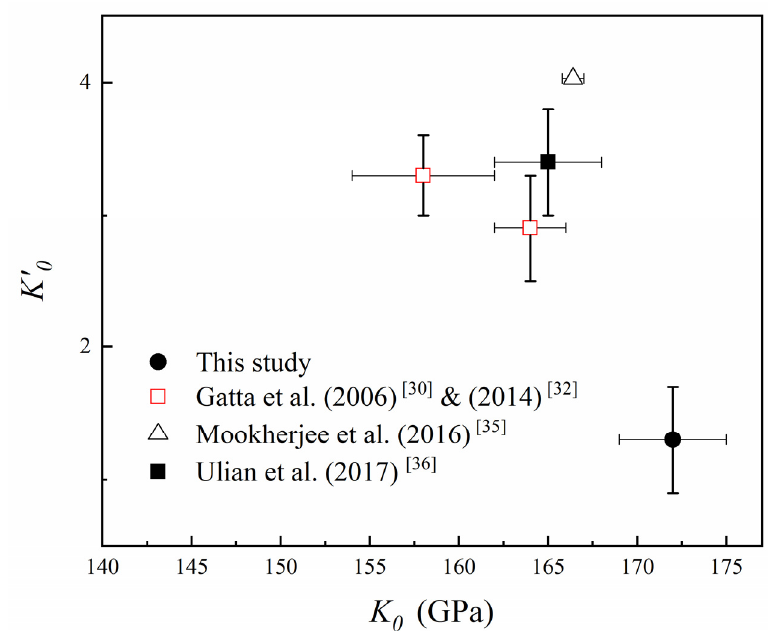
Figure 10. The relationship between K 0 and K’ 0 value. The red hollow square represents the data points of Gatta et al. (2006) [30] & (2014) [32], the black hollow triangle represents the data points of Mookherjee et al. (2016) [35], and the black solid square represents the data points of Ulian et al. (2017) [36].